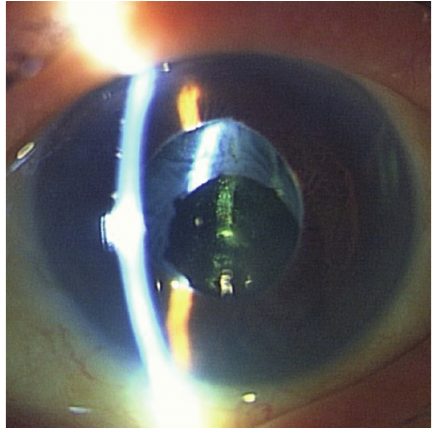
Figure 2: Photograph of the anterior segment of the left eye at the 7th day after the beginning of valganciclovir. Hypopyon in the anterior chamber, ciliary hyperemia, and corneal edema had disappeared. It was revealed that intraocular lens was in the lens capsule bag treated with posterior capsulotomy.